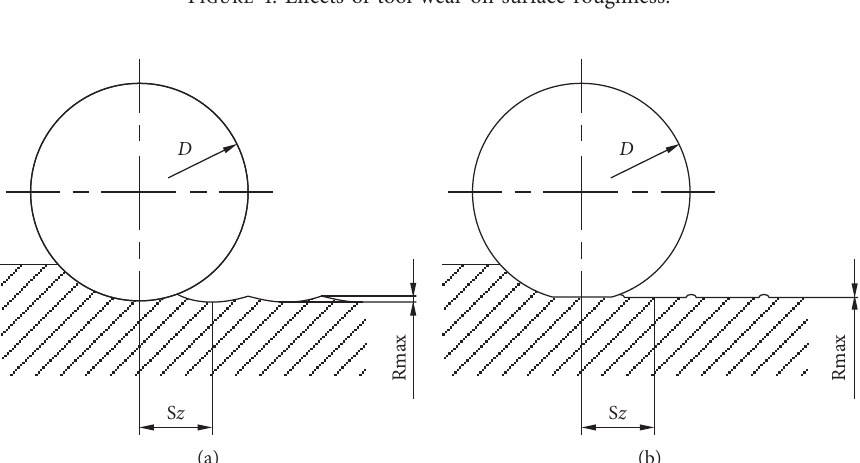
Figure 5: Effects of tool wear on tool shape. (a) Surface roughness of complete tool. (b) Surface roughness of worn